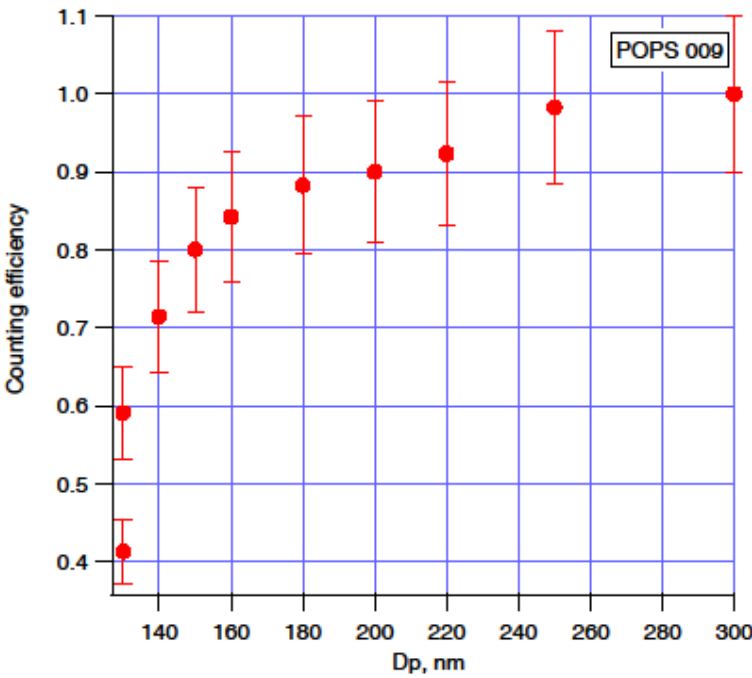
Figure 2. The counting e ffi ciency of one POPS as a function of the particle (ammonium sulfate) electrical mobility